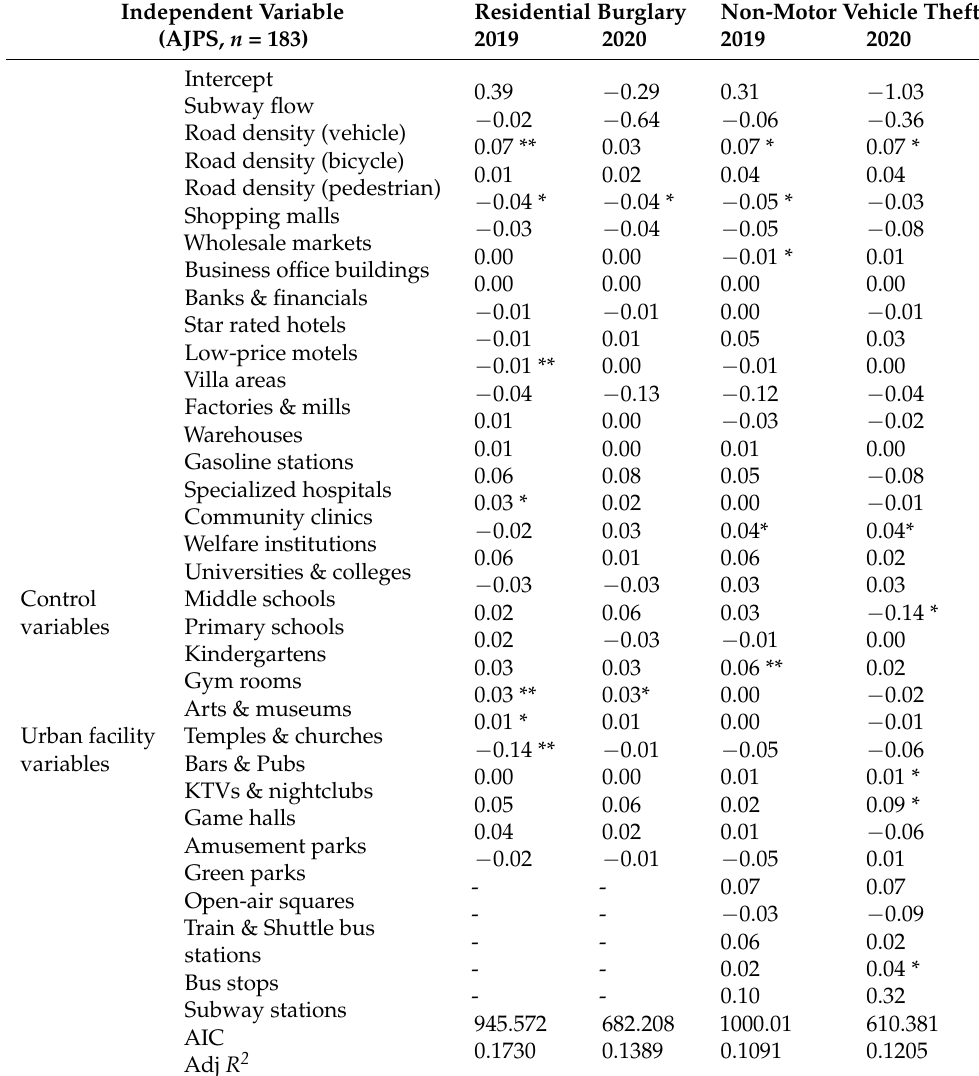
Table 5. The NBR regression results of residential burglary and non-motor vehicle theft during the pre- (2019) and pandemic (2020)